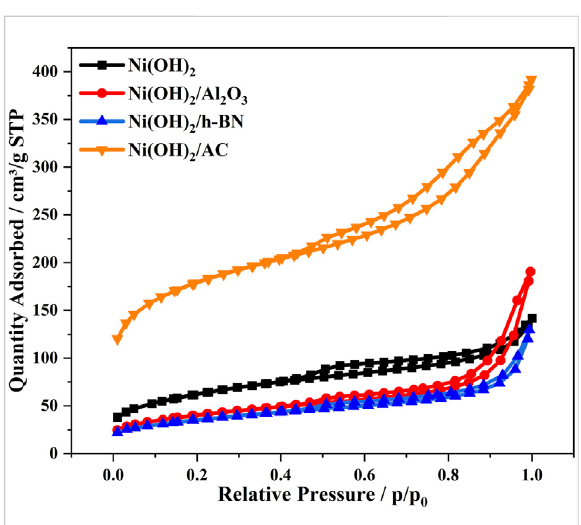
FIGURE 6 N 2 adsorption – desorption isotherms of different